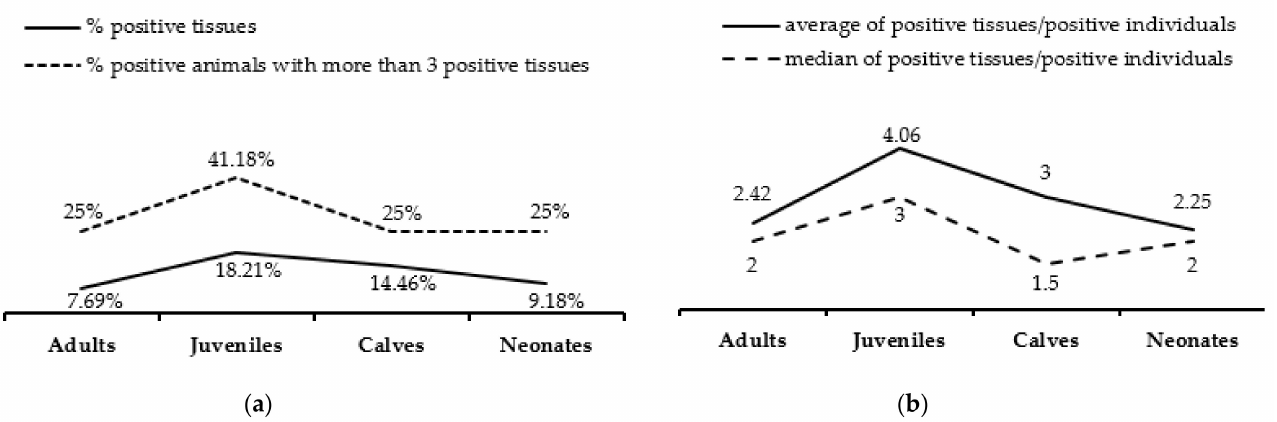
Figure 3. HV DNA detection stratified by age of the animal. ( a ) The percentage of all tissues that tested positive is shown, as is the percentage of infected individuals that had more than three positive tissues. ( b ) Average and median numbers of positive tissues per positive animal are